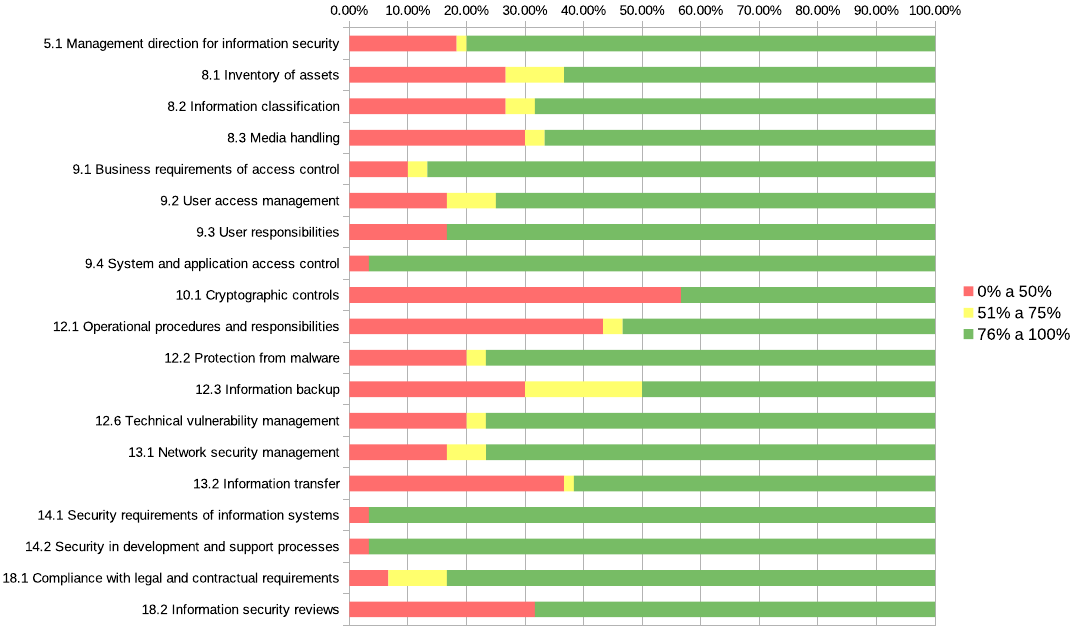
Figure 4. Type 1—Cumulative Acceptance Percentage of ISO-27001:2013 standard sections, by intervals.